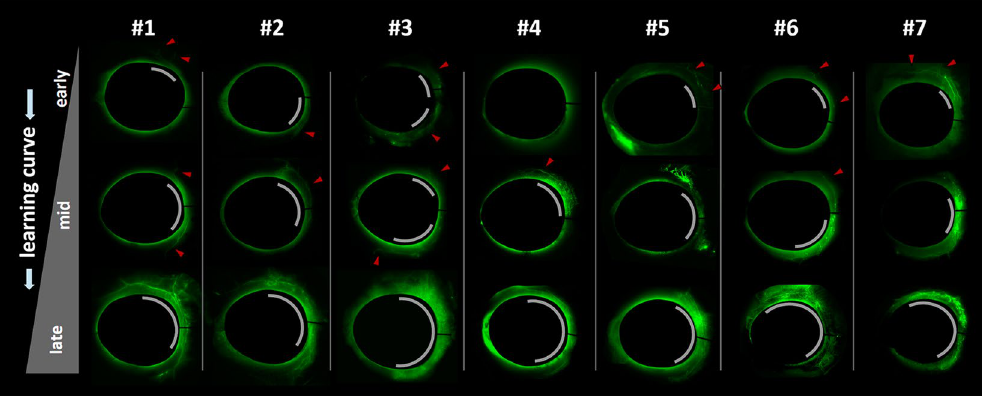
Figure 6. Fluorescent canalograms along the individual learning curve of trainees #1 through #7. All eyes are shown in frontal view with the superonasal quadrant in the upper right and the inferonasal, backhand ablation position in the lower right location. Microsphere canalogram casts from ablations of first eyes are visible at the top, from the middle of the learning curve in the center, and final eyes are shown at the bottom. Gray arcs indicate the extent of successful connection to the outflow tract. Most trainees initially only succeeded in ablation of the superonasal TM during the preferred, counterclockwise pass. Red arrowheads indicate aqueous veins that can be best seen in magnified